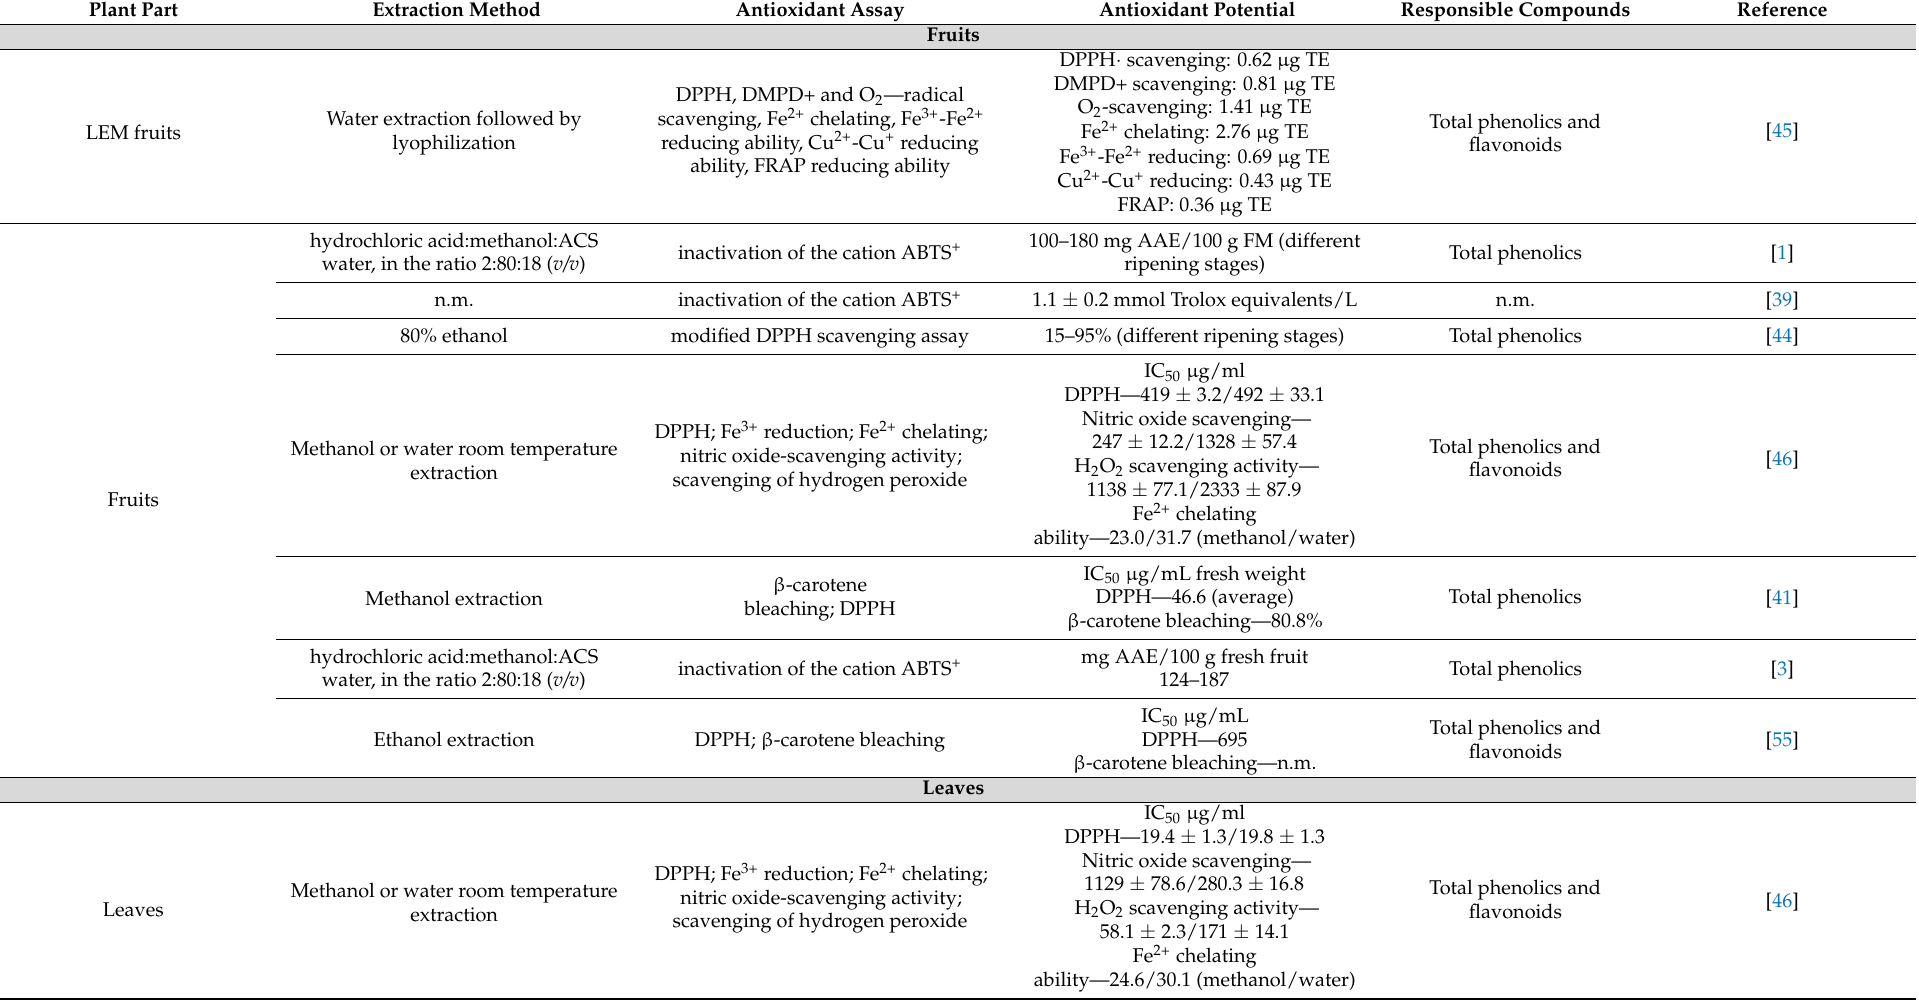
Table 12. Antioxidant properties of different extracts obtained from Mespilus germanica